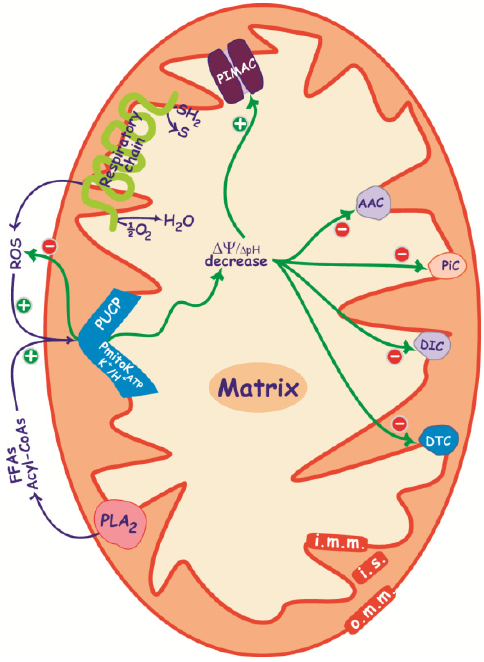
Figure 2. Effect of PmitoK and PUCP activity in DWM on ∆Ψ / ∆ pH, ROS production ATP and other transport systems under hyperosmotic stress. Under stress an increase of FFAs due to PLA activity and probably of their acyl-CoA derivatives is observed, as well as an 2 increased ROS production by respiratory chain and ATP synthesis inhibition, thus leading and PUCP activation. Once activated, both PmitoK and PUCP may cause to PmitoK ATP ATP ∆Ψ and ∆ pH decrease, which allows the prevention of further large-scale ROS production, according to a feedback mechanism. On the other side, ∆Ψ and ∆ pH decrease may modulate transport by impairing carriers and activating PIMAC. AAC, ADP/ATP carrier; DIC, dicarboxylate carrier; DTC, dicarboxylate-tricarboxylate carrier; PiC, Pi carrier; PIMAC, plant inner membrane anion channel; SH , reduced substrates; S, oxidized substrates; 2 , phospholipase A ; i.m.m., inner mitochondrial membrane; i.s., intermembrane PLA 2 2 space; o.m.m., outer mitochondrial membrane. ∆ pH is represented in a smaller font size since it represents a lower component of pmf with respect to ∆Ψ